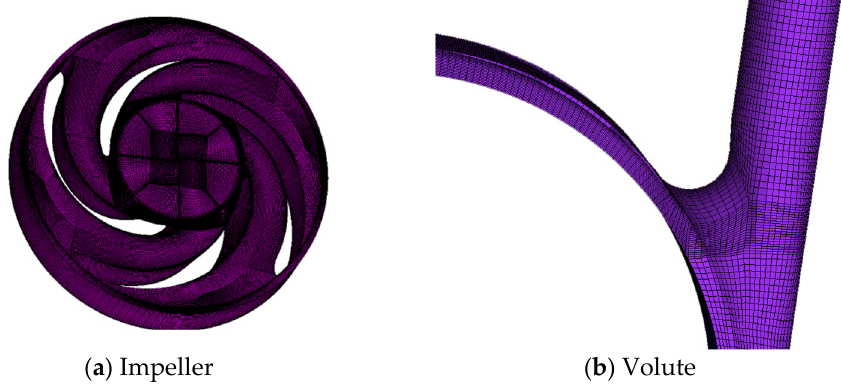
Figure 2. ( a , b ) Mesh generation of the flow domains.